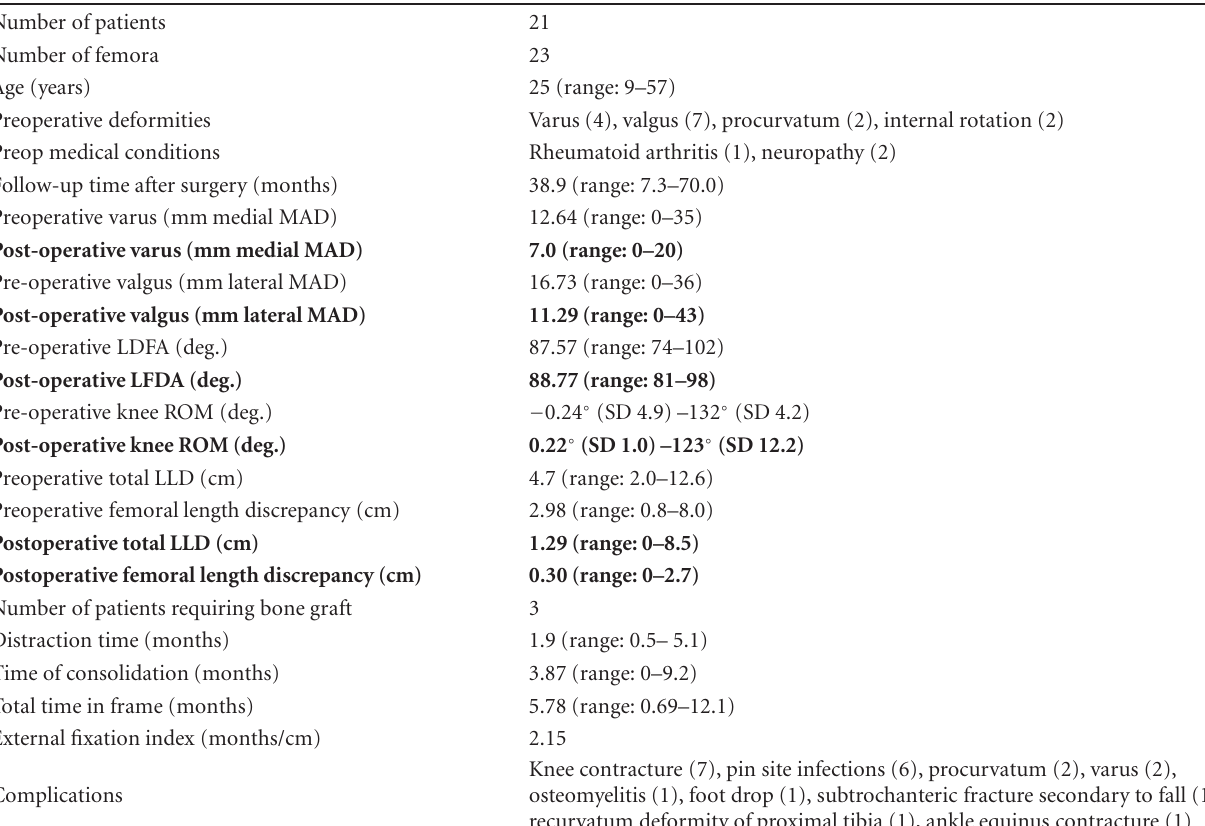
Table 2: Femoral Lengthening